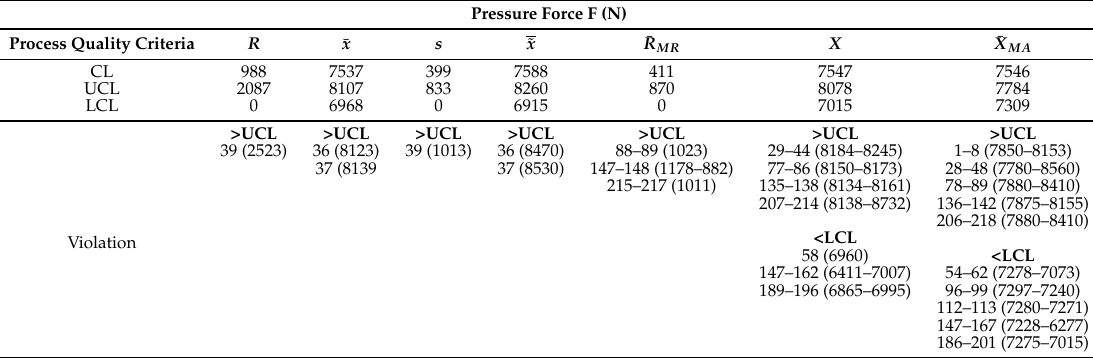
Figure 14. Control charts for technological parameter vibration signal of acceleration ( a ) diagram of variation range, ( b ) diagram of arithmetic mean, ( c ) diagram of standard deviation, ( d ) diagram of the median. Table 10. Values of the center line and control limits for the pressure